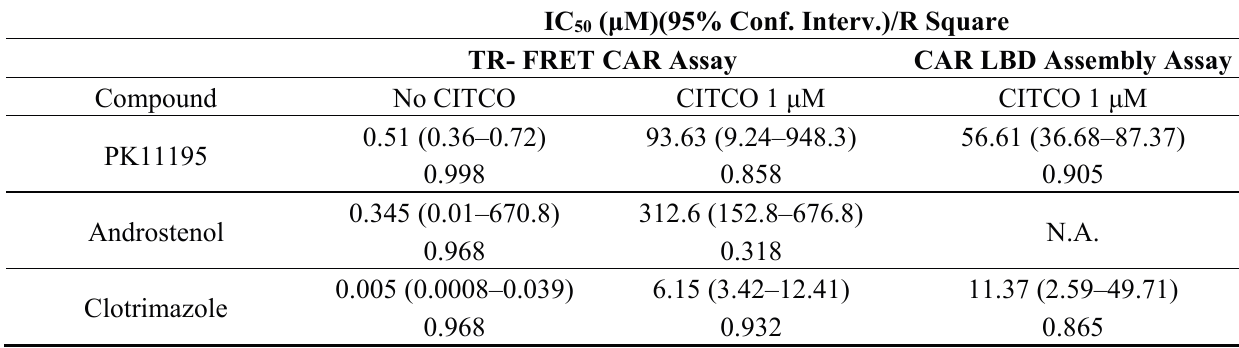
Table 1. Parameters of tested compounds to interact with human CAR